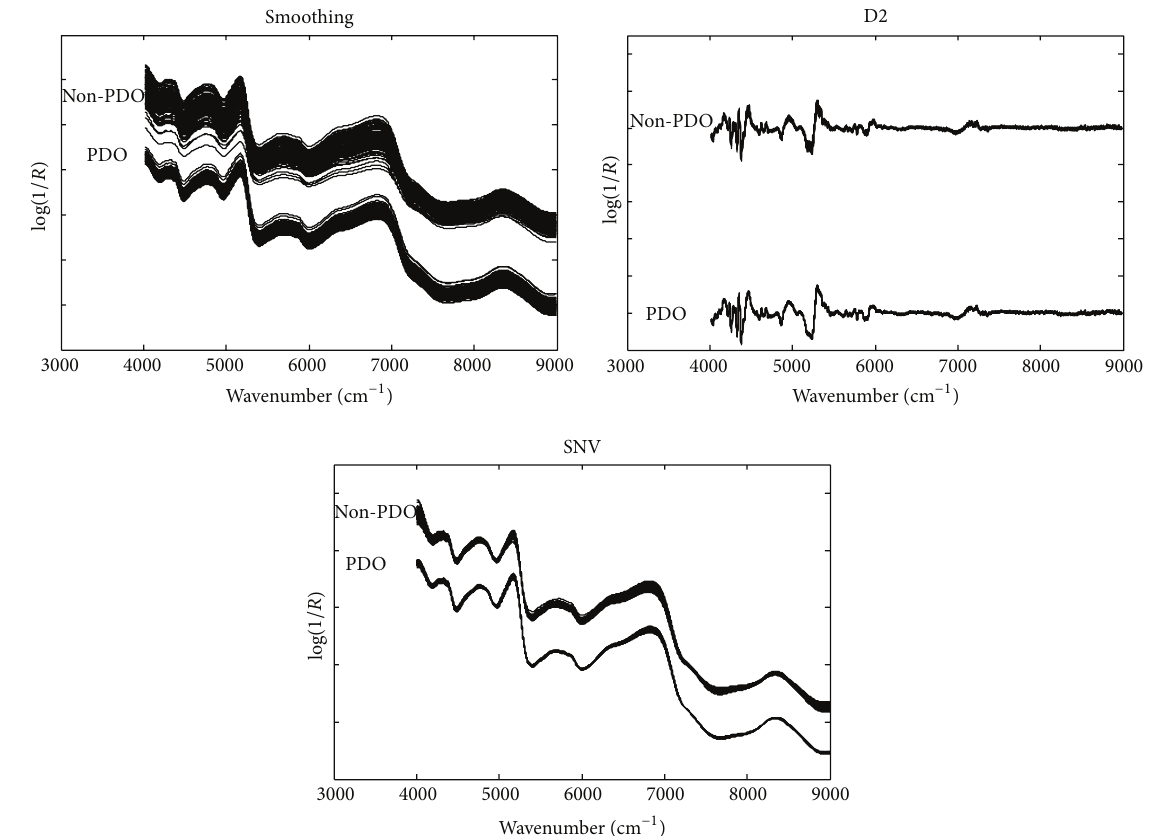
Figure 3: The smoothed, D2, and SNV spectra of PDO and non-PDO WLS objects. An extra shift of log (1/𝑅) was added to distinguish PDO and non-PDO objects.